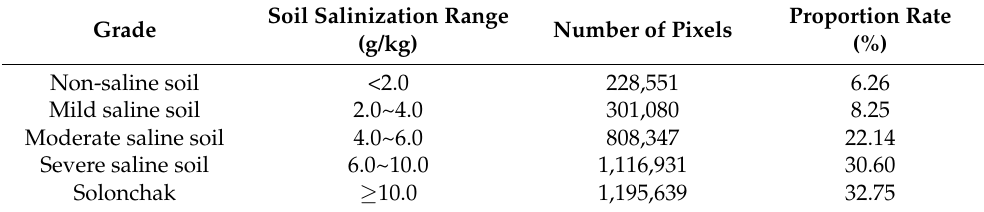
Table 3. Statistical results of soil salinity classification in Kenli District, Yellow River Delta.